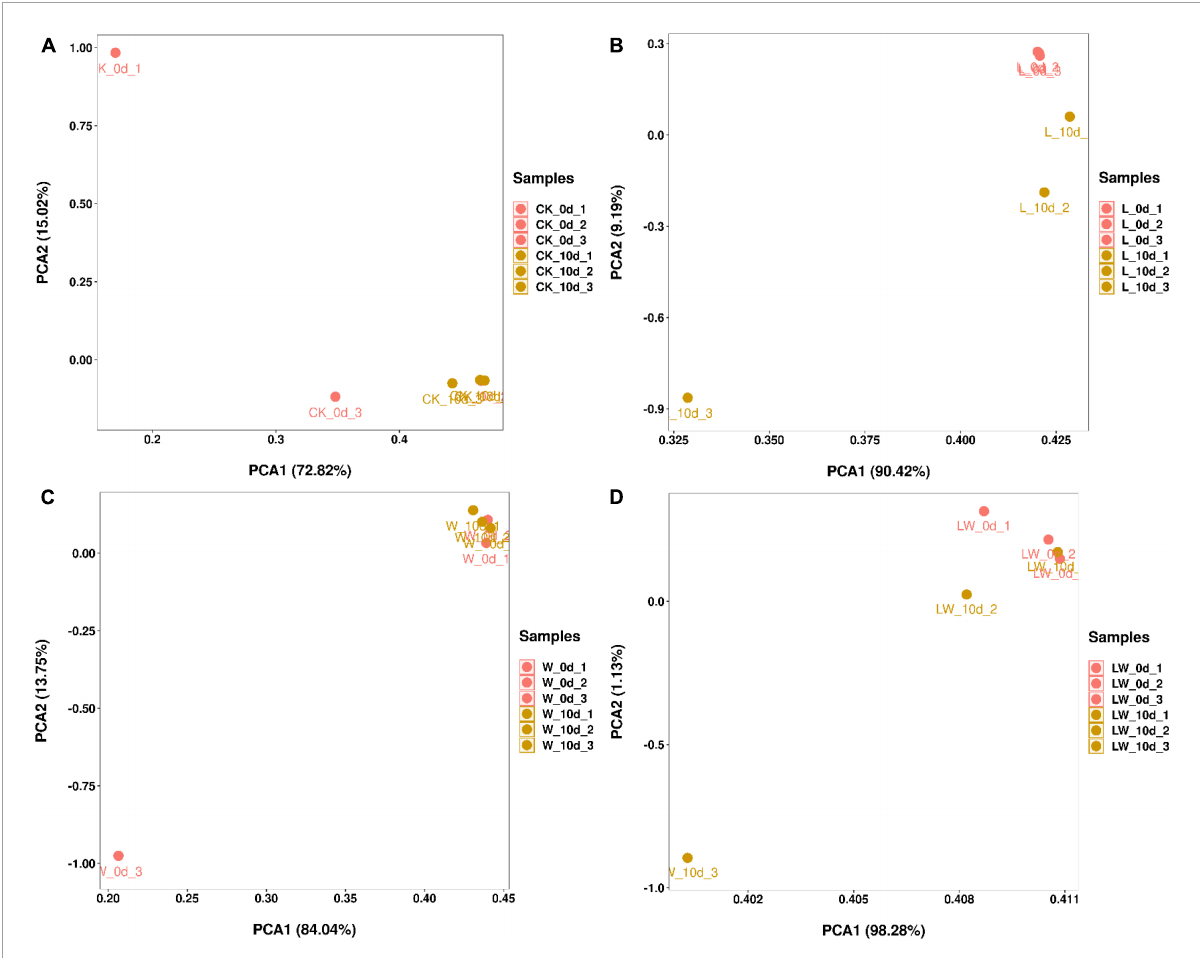
FIGURE2 The principal component analysis in Leymus chinensis silages ( n = 3). CK, ensiling L. chinensis with 2.00 ml/kg fresh weight (FW) of distilled water (A) ; L, ensiling L. chinensis with 2.00 g/t FW of lactic acid bacteria (LAB) inoculant and 2.00 ml/kg FW of distilled water (B) ; W, ensiling L. chinensis with 100 ml/kg FW of distilled water (C) ; LW, ensiling L. chinensis with 2.00 g/t FW of LAB inoculant and 100.0 ml/kg FW of distilled water (D)